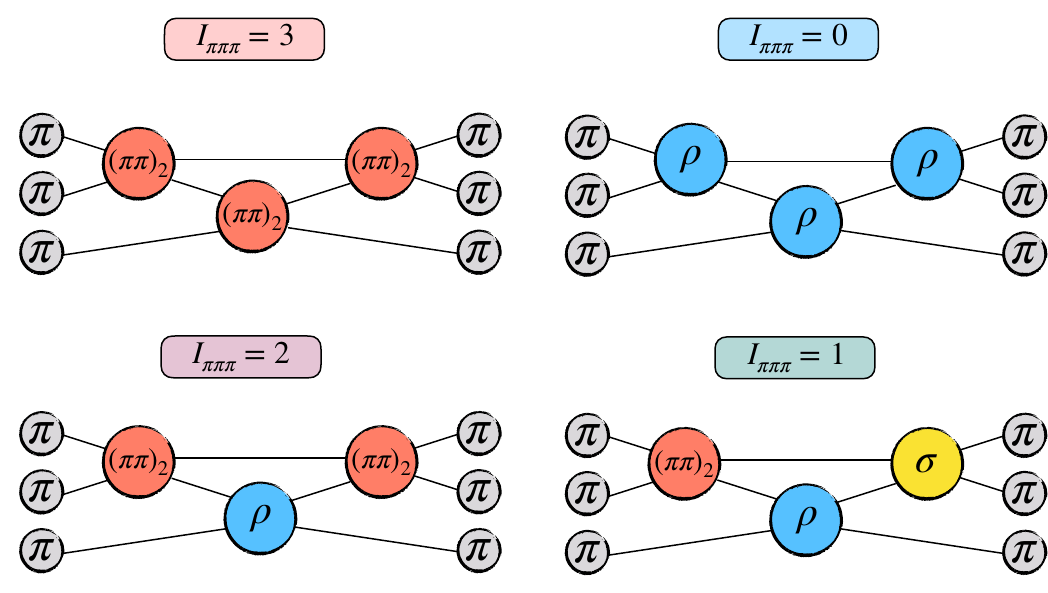
Figure 1 . Sketch of subchannels for pairwise interactions present in each three-pion system with (cid:12)xed overall isospin, I (cid:25)(cid:25)(cid:25) . For I (cid:25)(cid:25)(cid:25) = 0 and 3, only one subchannel is present, having I (cid:25)(cid:25) = 1 and I (cid:25)(cid:25) = 2, respectively. For I (cid:25)(cid:25)(cid:25) = 2, two subchannels are present, with I (cid:25)(cid:25) = 1 and 2, implying that the three-particle quantization condition lives in a two-dimensional (cid:13)avor space. For I (cid:25)(cid:25)(cid:25) = 1, all three two-pion subchannels contribute ( I (cid:25)(cid:25) = 0 ; 1 ; and 2), leading to a three-dimensional (cid:13)avor space. For convenience, we use the shorthand notation ( I (cid:25)(cid:25) = 0) ( I (cid:25)(cid:25) = 2) \( (cid:25)(cid:25) ) 2 ", in which we label (when possible) the two-pion subchannels by the renonances (cid:17) present in